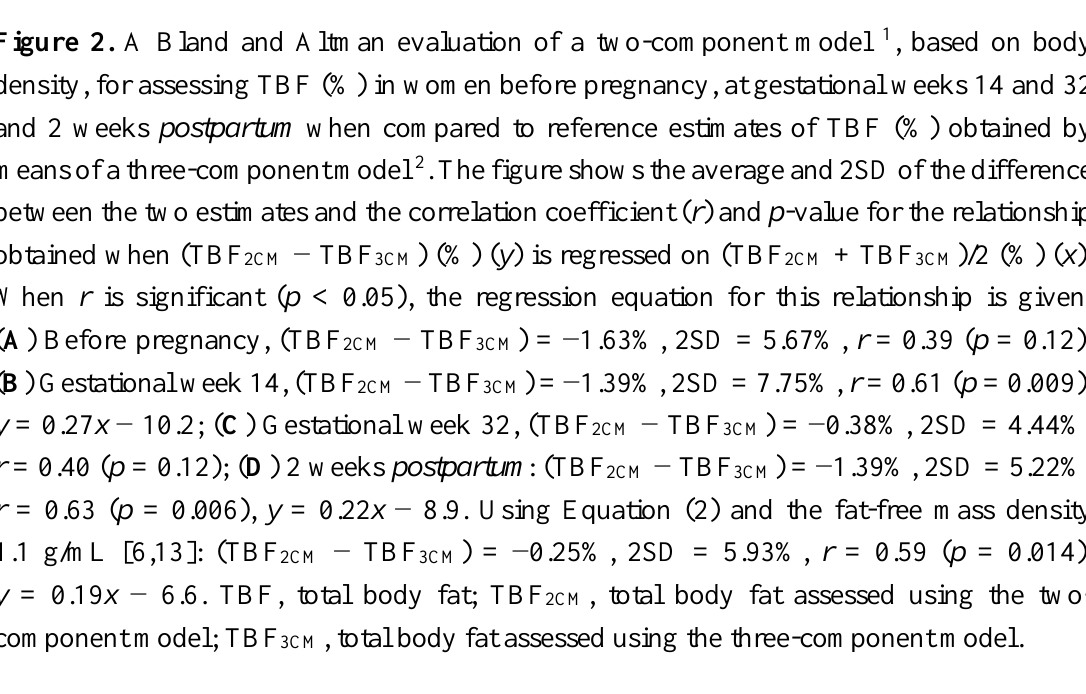
Figure 2. A Bland and Altman evaluation of a two-component model 1 , based on body density, for assessing TBF (%) in women before pregnancy, at gestational weeks 14 and 32 and 2 weeks postpartum when compared to reference estimates of TBF (%) obtained by means of a three-component model 2 . The figure shows the average and 2SD of the difference between the two estimates and the correlation coefficient ( r ) and p -value for the relationship obtained when (TBF 2CM − TBF 3CM ) (%) ( y ) is regressed on (TBF 2CM + TBF 3CM )/2 (%) ( x ). When r is significant ( p < 0.05), the regression equation for this relationship is